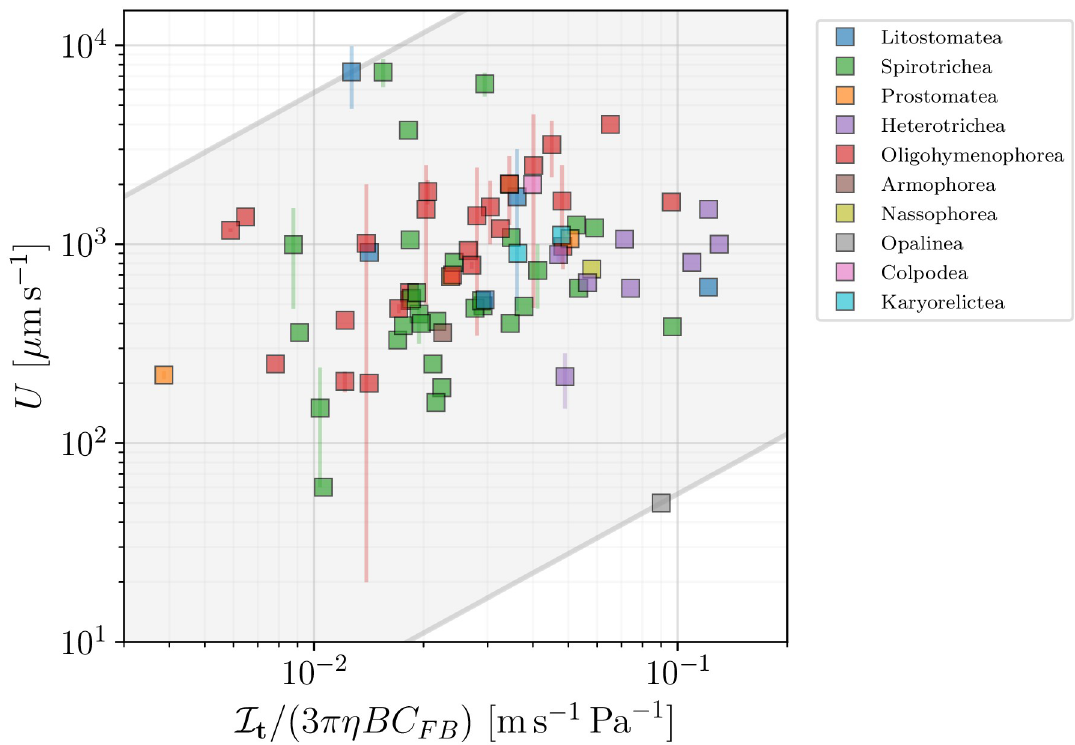
Fig 21. The swimming speed U for ciliates plotted versus the numerical factor accompanying the constant tangential stress assumed in model (A) and Eq (39). The shaded area encloses all organisms and serves as an estimate of the average effective tangential stress for all organisms, with the lower bound of τ min = 0.55 mPa, and the upper bound of τ max = 580 mPa. Colours distinguish between classes of ciliated organisms. The scatter of data suggests that only a large range of values for the stress of individual organisms can be